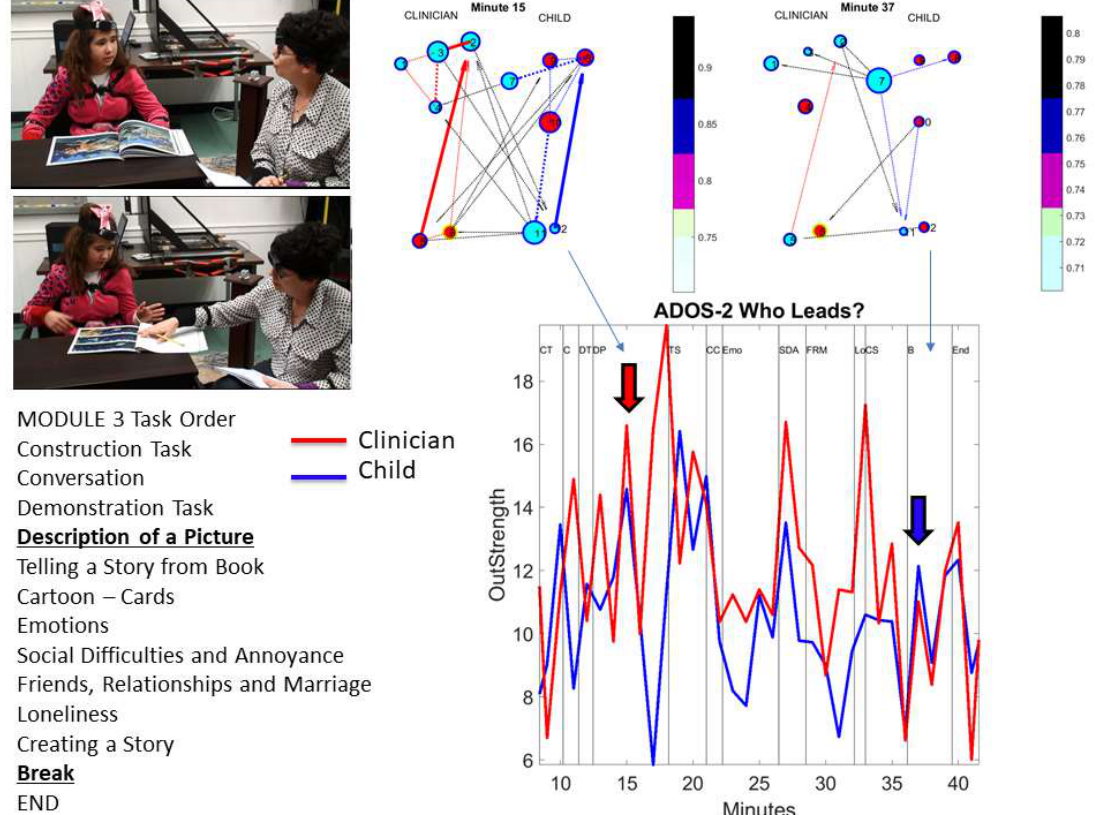
Figure A1. Automatically tracking who leads in the dyadic interaction taking place as the ADOS-2 test [60] unfolds (to diagnose autism spectrum disorders). Two frames depicting the clinician and child engaged in the test. Both participants are wearing a grid of APDM Opal IMUs 128 Hz, Portland OR, on the torso, lumbar, right and left wrists, and right and left ankles (along with positional head and wrist Polhemus Latus sensors, 188 Hz, Colchester VT). The 12 IMUs simultaneously co-register acceleration, gyroscope, magnetometer, and temperature data. Acceleration data is used here to demonstrate the minute-by-minute states of the network conformed by the 12 nodes (1–6 on the clinician and 7–12 on the child). The ADOS-2 Module 3 for the verbal child was administered with tasks in the order depicted and using the task initials to represent the minute-by-minute activity. The network outgoing strength (obtained from the weighted sum of the links outgoing from a node i , times the maximal coherence value to another node j ) defines a profile revealing leading activity for the child and clinician. For simplicity, the network states for the corresponding minute-peak activity are shown. One is for the peak at minute 15—when the clinician leads the child (during the Description of a Picture, DP task) and the other is at minute 37—when the child leads the clinician during the Break, B task. Vertical lines delineate the tasks’ segments (denoted by the initials) in the order in which they occurred. The labeling and analyses are completely automated.